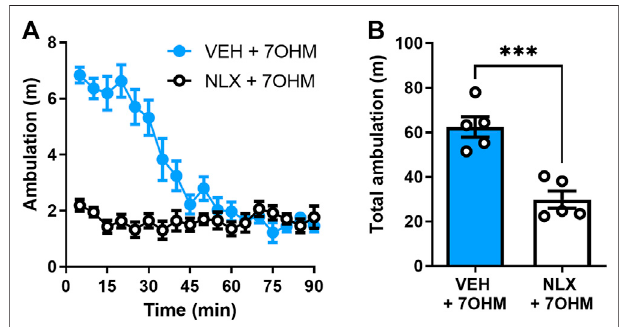
FIGURE 1 | Blocking μ OR attenuates 7-hydroxymitragynine (7OHM) induced hyperlocomotion. (A) 90-min ambulation time course of wild-type, C57Bl/6 male mice ( n (cid:2) 5 per group) treated with 7-hydroxymitragynine (3 mg · kg − 1 , i.p.) after pretreatment with the vehicle (s.c.) or naloxone (1 mg · kg − 1 , s.c., NLX) injection (10 min prior to 7-hydroxymitragynine injection). (B) Total ambulation (area under the curve) for the same data set. *** p < 0.001 (for details, see Supplementary Table S2